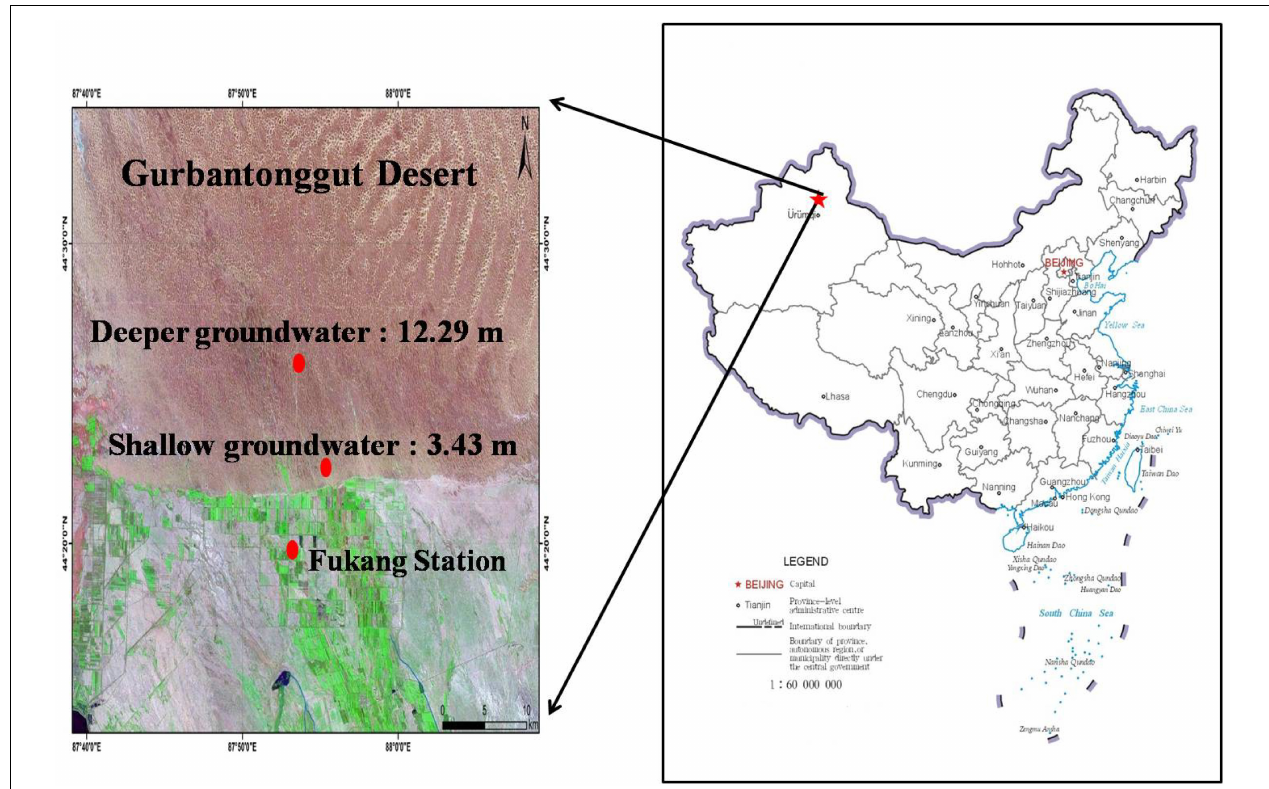
FIGURE 1 | Location of the two experimental study sites. The shallow groundwater site has a groundwater depth of 3.43 m, and the deeper groundwater site has a groundwater depth of 12.29